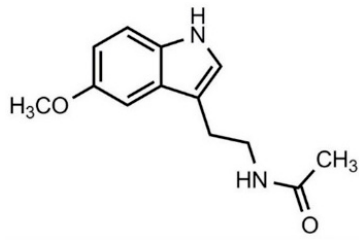
Figure 1. Structure of melatonin (MEL).